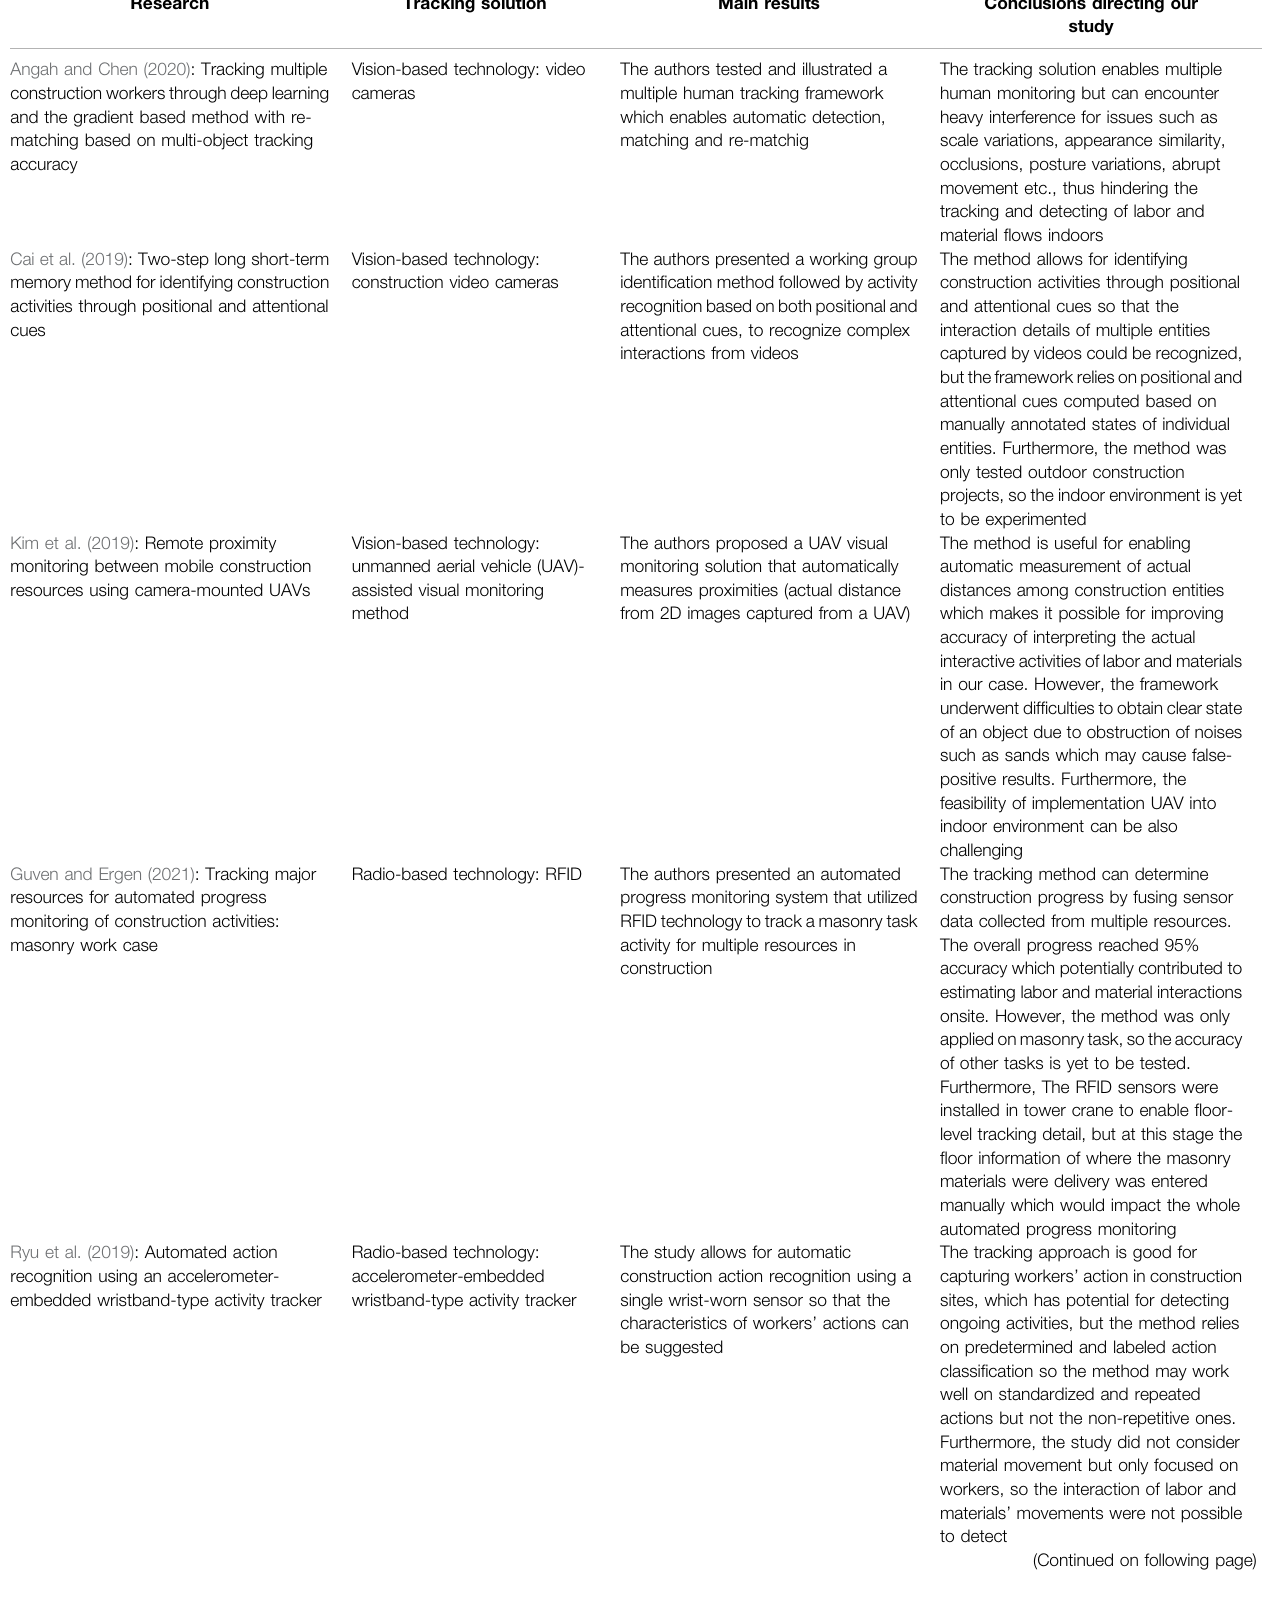
TABLE 1 | Previous research and conclusions related to our